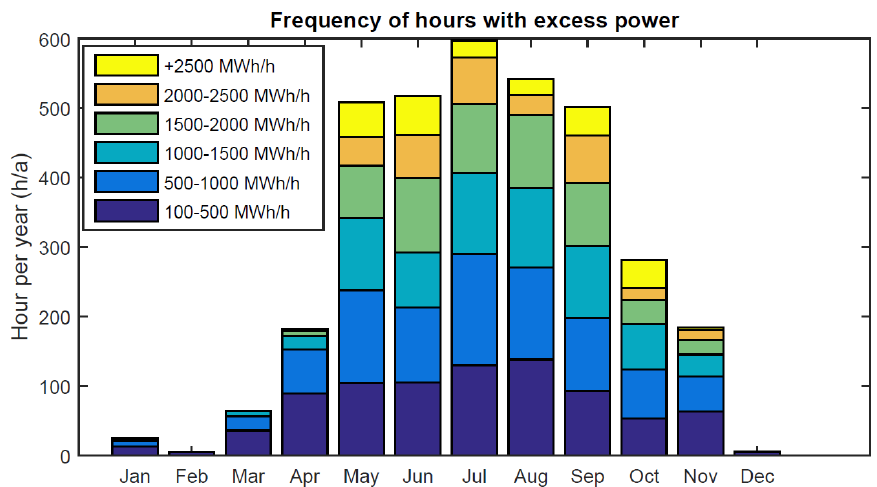
Figure 13. The frequency and magnitude of excess power in different months of the year (conditions for Case I, see Table